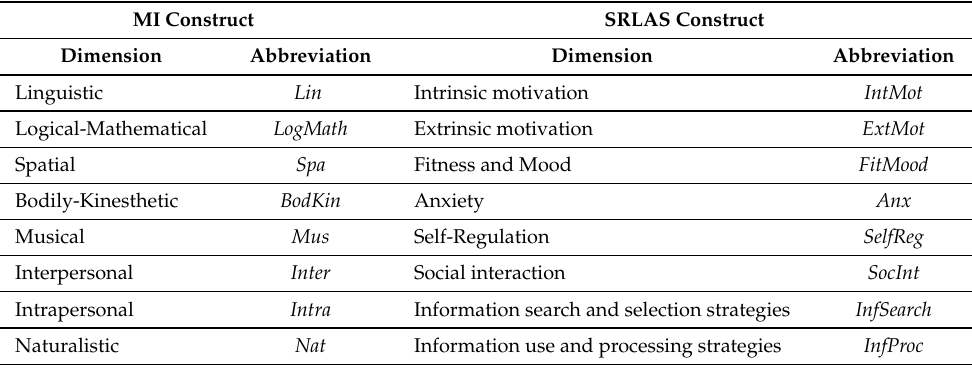
Table 2. Dimensions for the MI and SRLAS